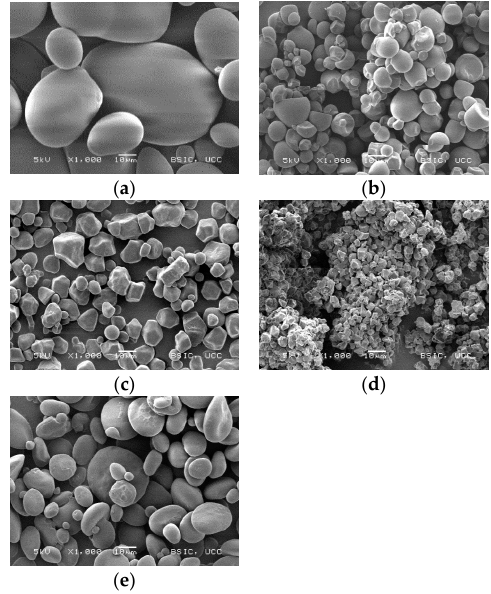
Figure 1. Micrographs of ( a ) potato starch, ( b ) tapioca starch, ( c ) corn starch, ( d ) rice starch, ( e ) wheat starch (Magnification 1000×).